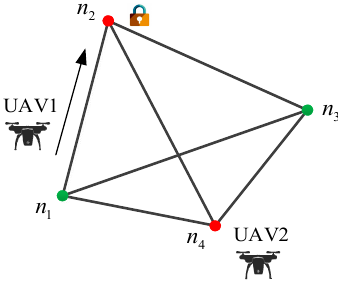
Figure 1. Target exclusion mechanism.